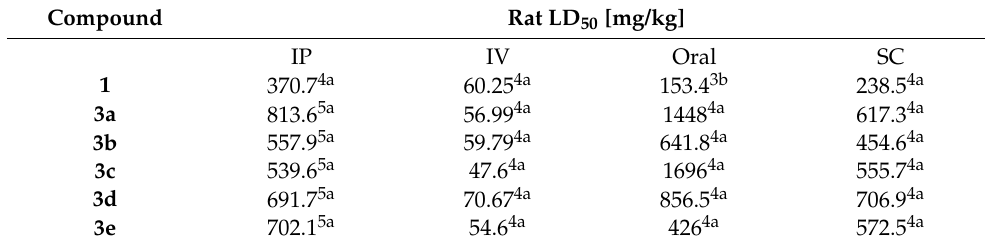
Table 2. Acute rat toxicity predicted via GUSAR software.